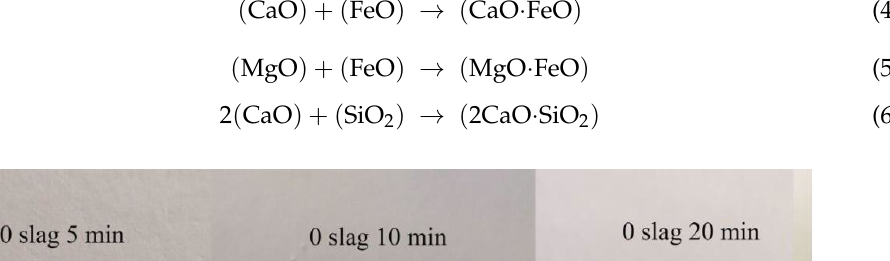
Figure 7e and Table 4 present the phase changes in slag and the dissolution of lime after adding 10% ATN. No prominent new phases are observed. Both Al and Na are found in the slag and invading lime cracks, and Ti is not detected because the added TiO 2 content is only 1.8%. The Fe content in the intrusive phase is 33.7%, which is higher than those in samples 0, A, and T, indicating that adding ATN also promotes the rapid dissolution of lime. Therefore, the dissolution rates in the first and second stages for sample ATN are higher than those following the addition of Al 2 O 3 or TiO 2 .